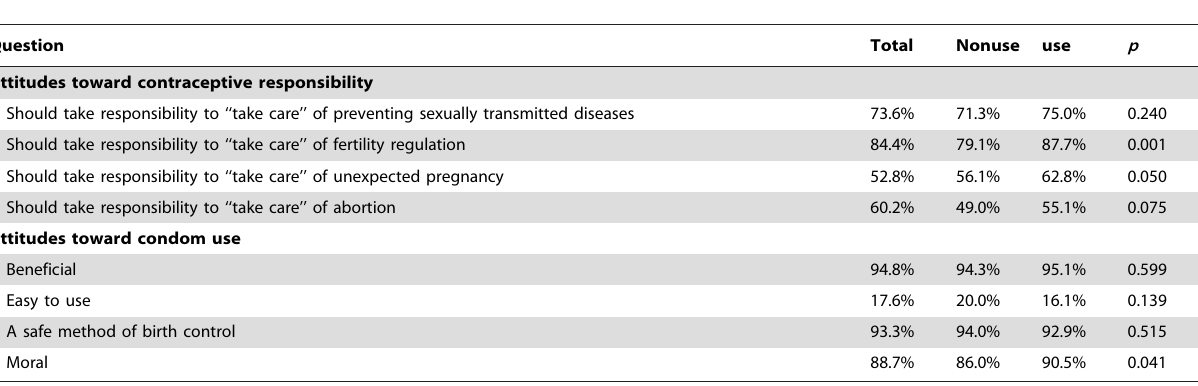
Table 2. Descriptions for attitudes toward reproductive health (individual items and percent correct).